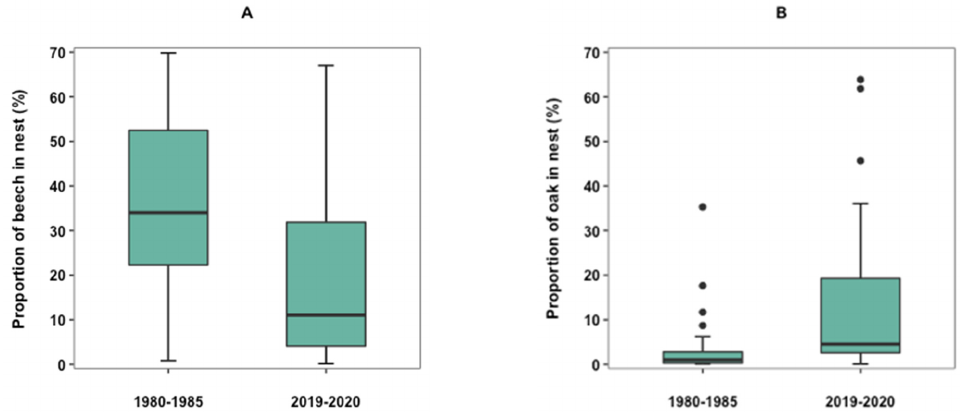
Figure 2. Boxplots exhibiting the proportion of beech ( A ) and oak ( B ) in nests from 1980 to 1985 (n = 82) and nests from 2019 to 2020 (n = 66). Boxes represent the 25 to 75% interquartile range, and the lines are the median values. Error bars extend upward from the third quartile to the maximum and the other extends downward from the first quartile to the minimum. Outliers are represented by dots.